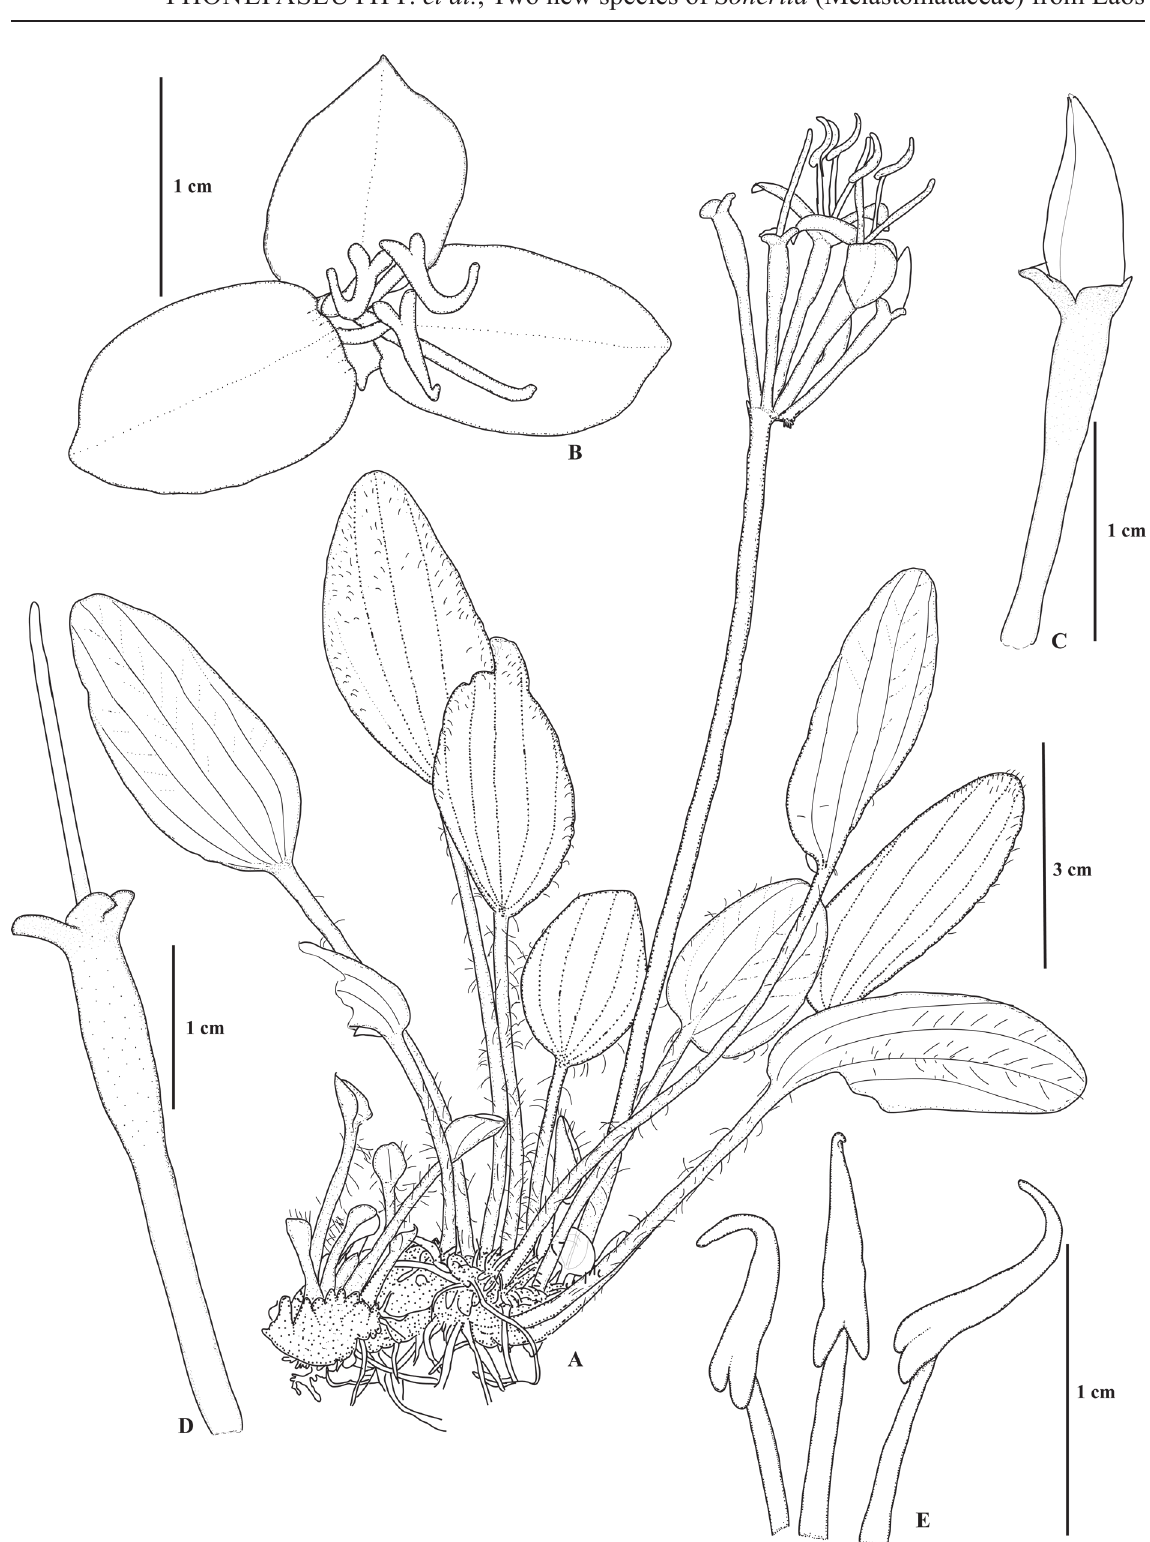
Fig. 1. Sonerila erectifolia Phonep., Soulad. & Tagane sp. nov. A . Habit. B . Front view of flower. C . Flower bud. D . Hypanthium and style. E . Stamens. Line drawings from holotype ( Souladeth et al. L3950 ) by K.